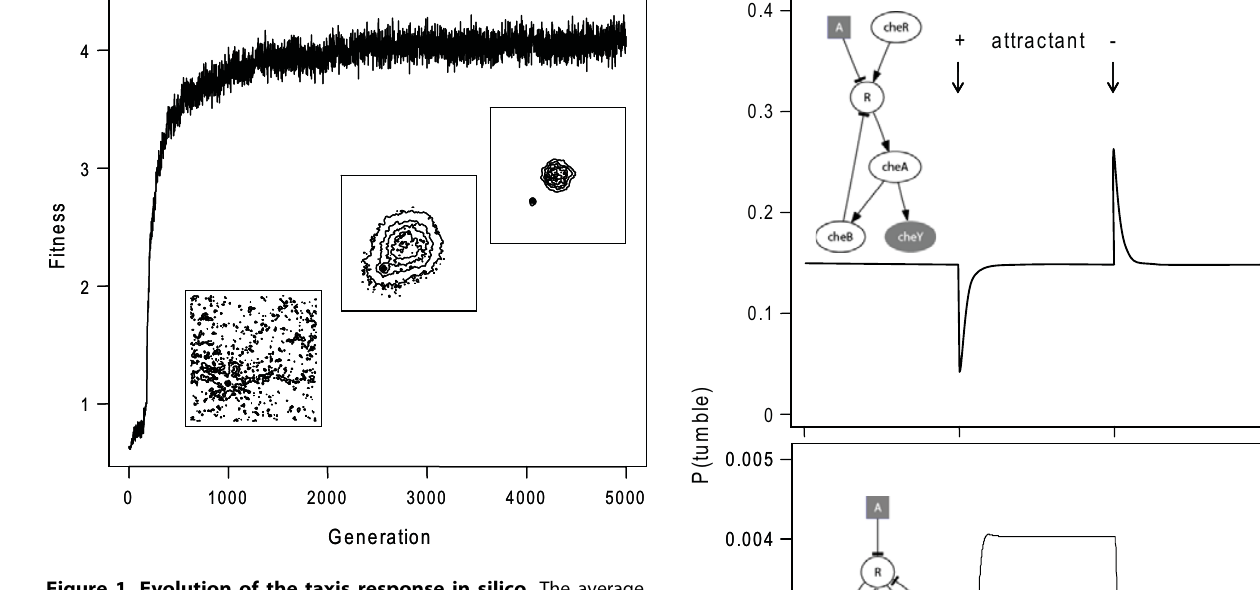
Figure 1. Evolution of the taxis response in silico. The average fitness in an evolving population of virtual bacteria. The inset shows the time-averaged distribution of positions of the population at generation 0, 200 (corresponding to a fitness of approximately 2.0), and 5,000 (final generation) as a contour plot. Areas enclosed by darker lines indicate more time spent there. Note that in these simulations the entire population starts at grid location (30,30) while stimulus source is fixed at (50,50).